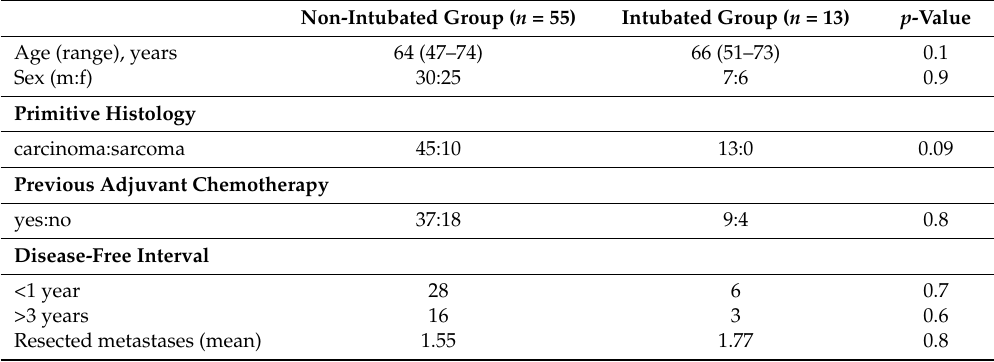
Table 1. Biological features of the two groups.